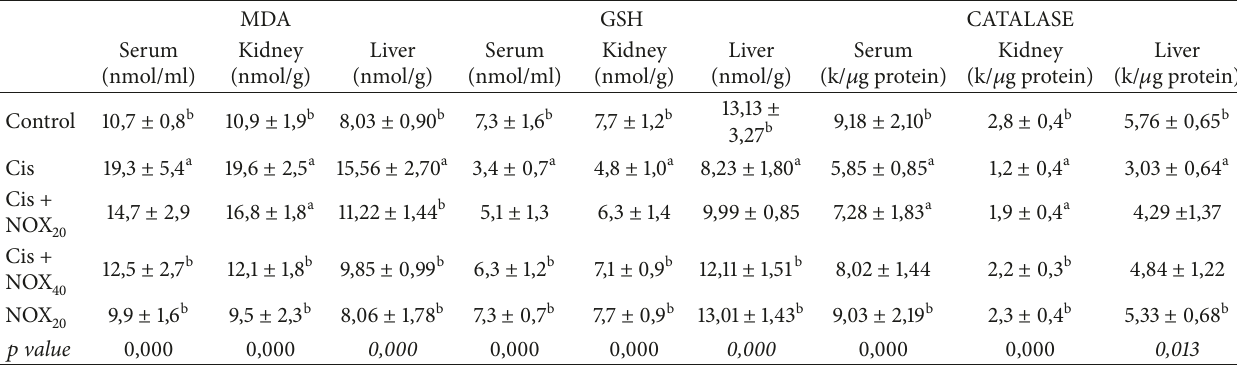
Table 1: Effects of cisplatin (7mg/kg), naringenin oxime (20 mg/kg), Cis + NOX 20 , and Cis + NOX 40 on catalase activities, MDA, and GSH level in serum, kidney, and liver of rats.